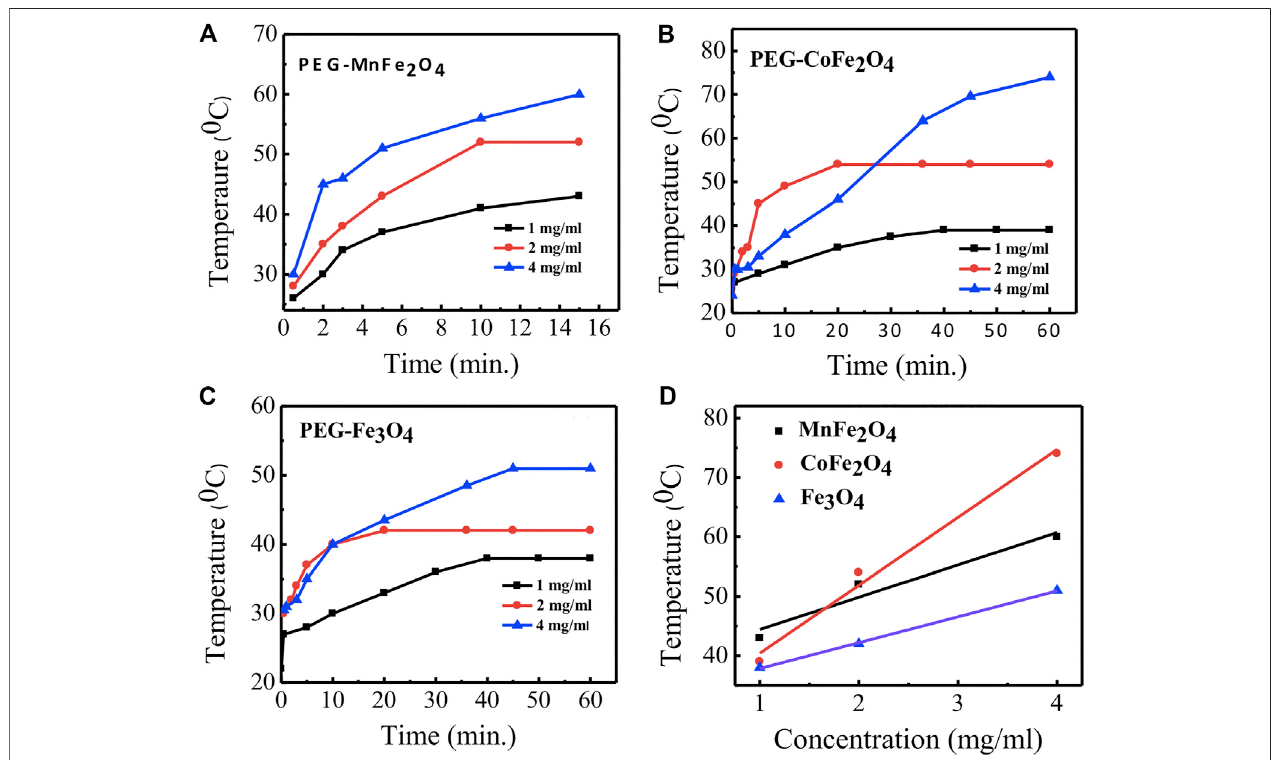
FIGURE 9 | Time dependence of temperature rise of particles at a concentration of 1, 2, and 4 mg/ml in water for different compositions coated with PEG (A) MnFe